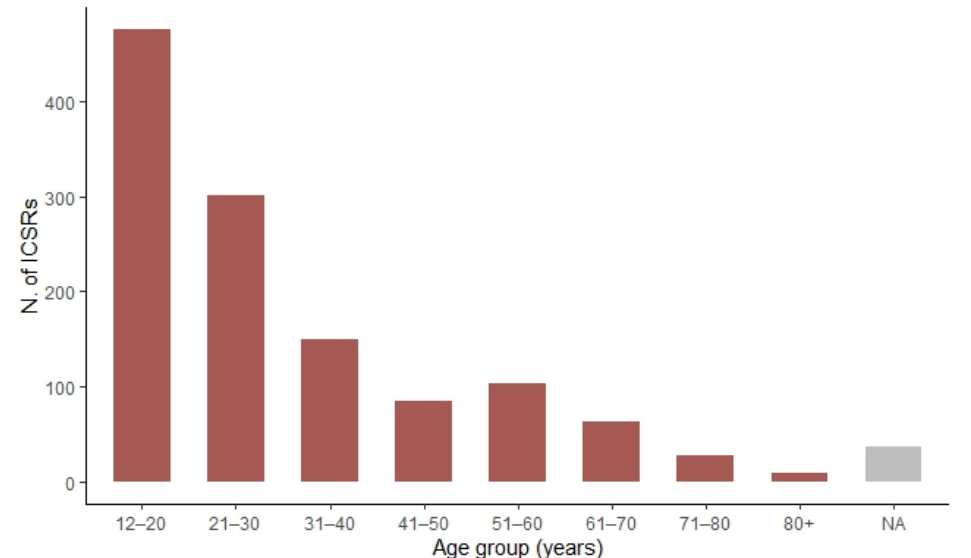
Figure 4. Distribution of cases of myocarditis and pericarditis following mRNA COVID-19 vaccines with stratification by age group.